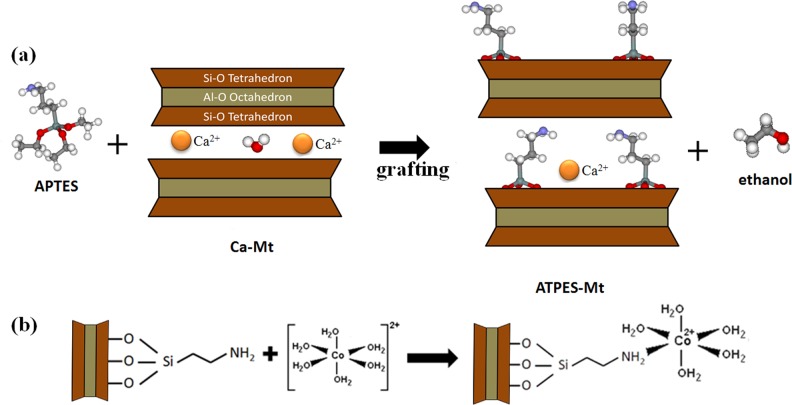
The synthetic procedure for APTES-Mt composite (a) and the cartoon illustration the coordination bond between Co(II) and APTES-Mt (b).